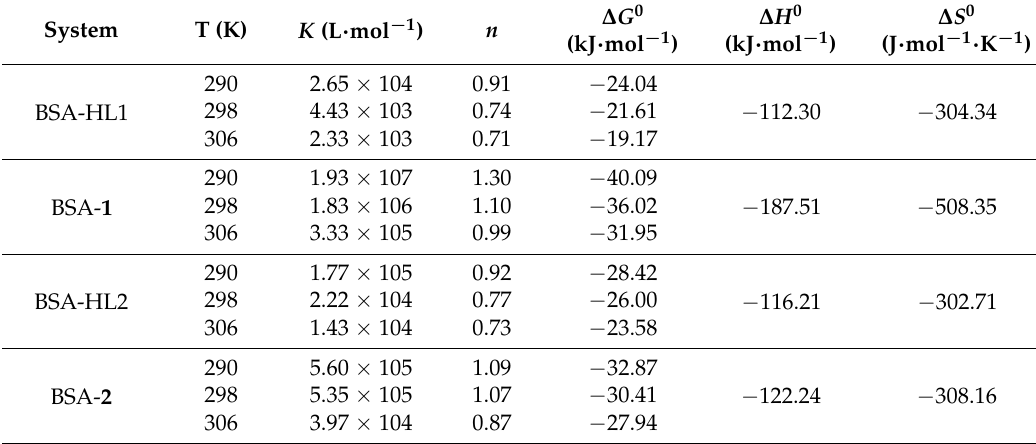
Figure 5. The logarithmic plots of the fluorescence quenching of BSA by HL1, HL2, 1 and 2 at different temperatures: 290 K, 298 K, 306 K. Table 6. The binding constants and thermodynamic parameters of BSA by HL1, HL2, 1 and 2 at different temperatures: 290 K, 298 K, 306 K.